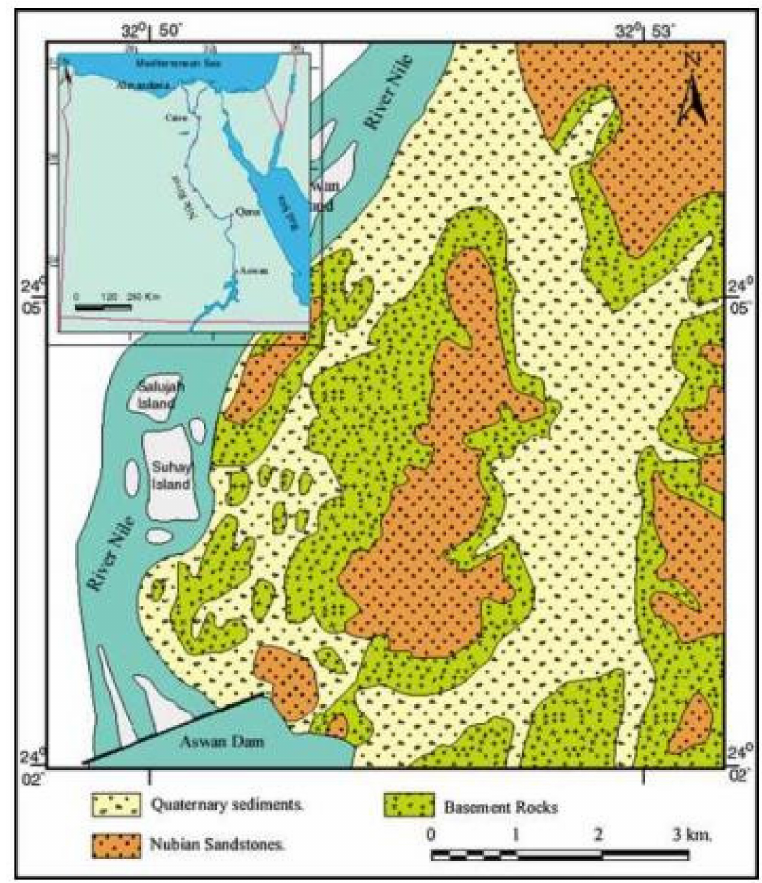
Figure 5. Geology of the study area